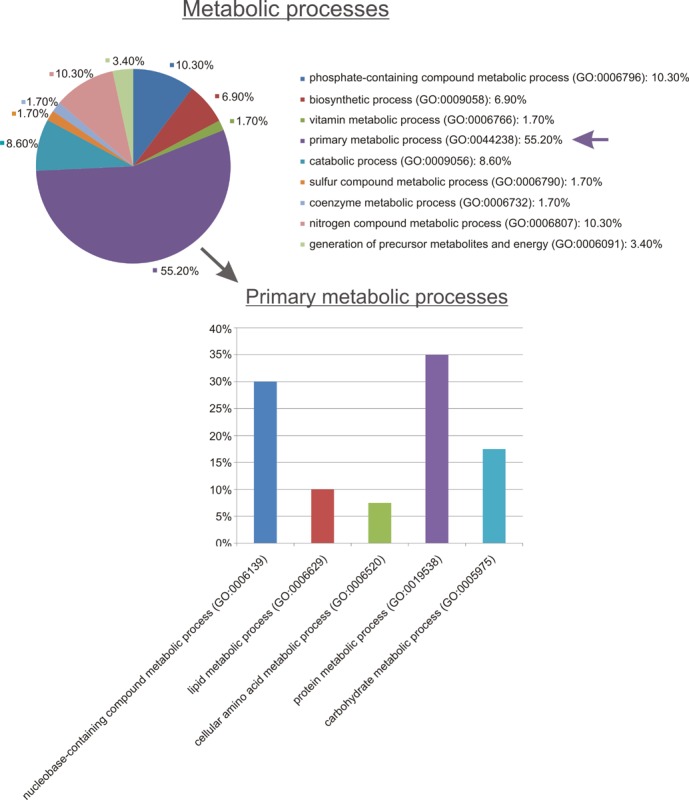
Metabolic processes related to proteins affected by DIO1 expression in ccRCC cells.Analysis was performed using PANTHER (www.pantherdb.org).